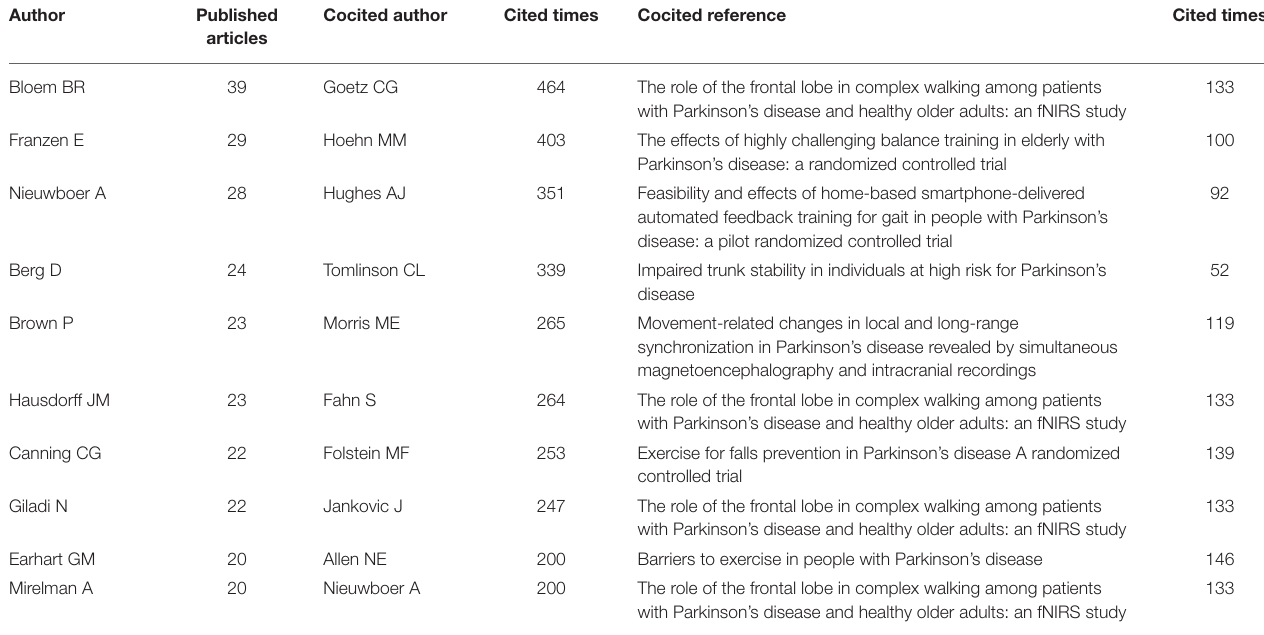
TABLE 1 | Top 10 authors, co-citing authors, and co-citing references of exercise on PD.